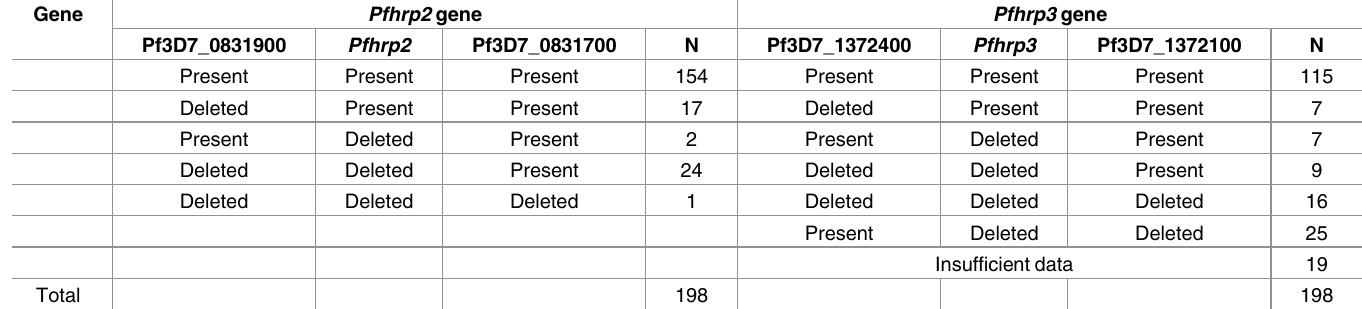
Table 3. Combination of Pfhrp2 and Pfhrp3 genes and respective flanking genes in P . falciparum samples collected in Brazil (198 samples). Gene